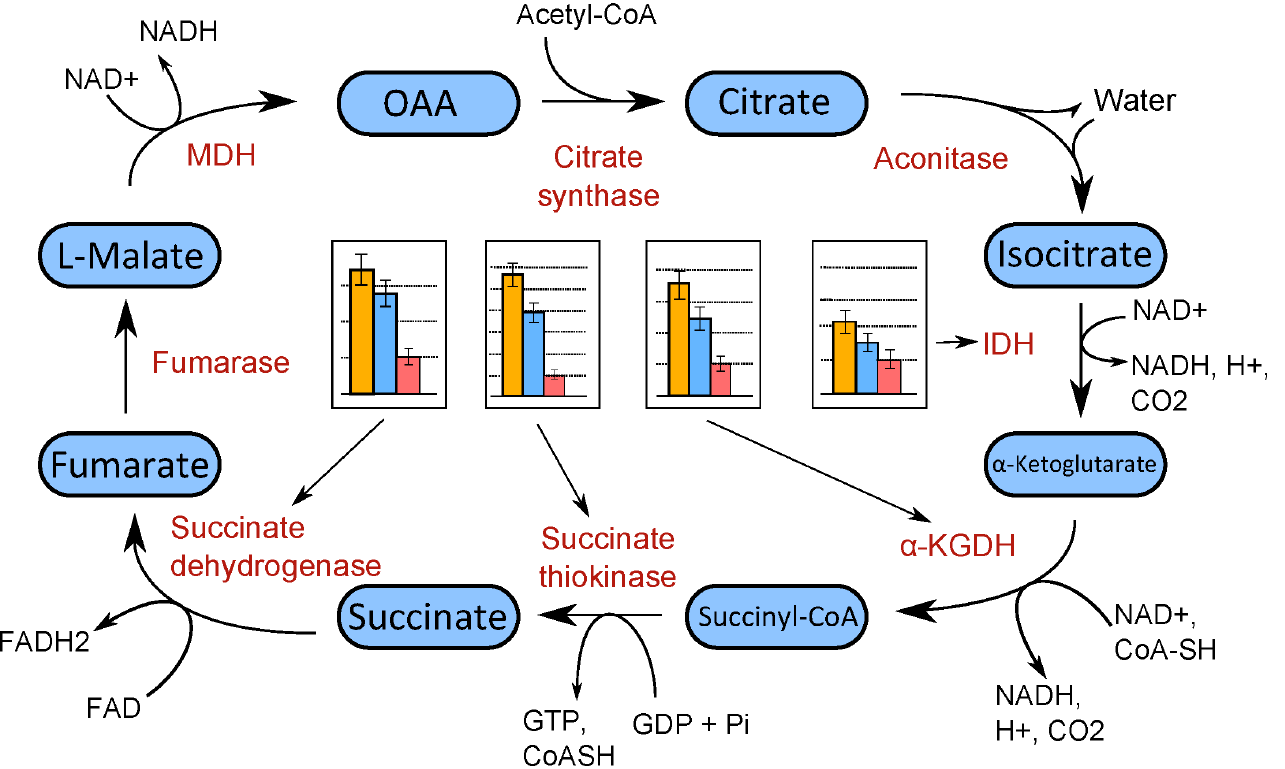
Fig 2. Expression levels of key enzymes of the TCA cycle in P – (yellow), WT (blue), and P+ (red) strains.